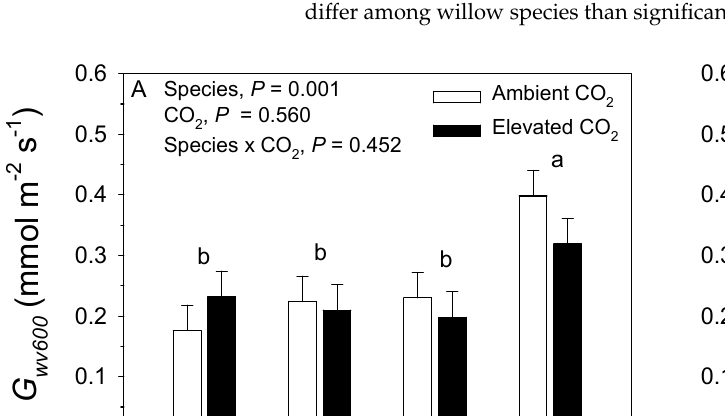
Figure 2. ( A ) Assimilation at 600 ppm (A 600 ) (mean ± SE) by willow species and CO 2 treatments, 2017, ( B ) by willow species and moisture stress treatments, 2017, ( C ) by willow species and CO 2 treatments, 2018, and ( D ) by willow species and fertilization treatments, 2018. If lower case letters differ among willow species than significantly different using Tukey’s mean separation test ( p = 0.05).